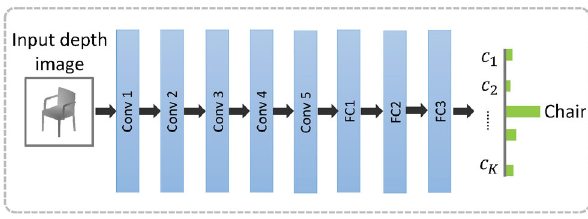
Fig. 4 Architecture of our shape classifier, which is borrowed from AlexNet [25]. It takes depth images as input, and outputs classification